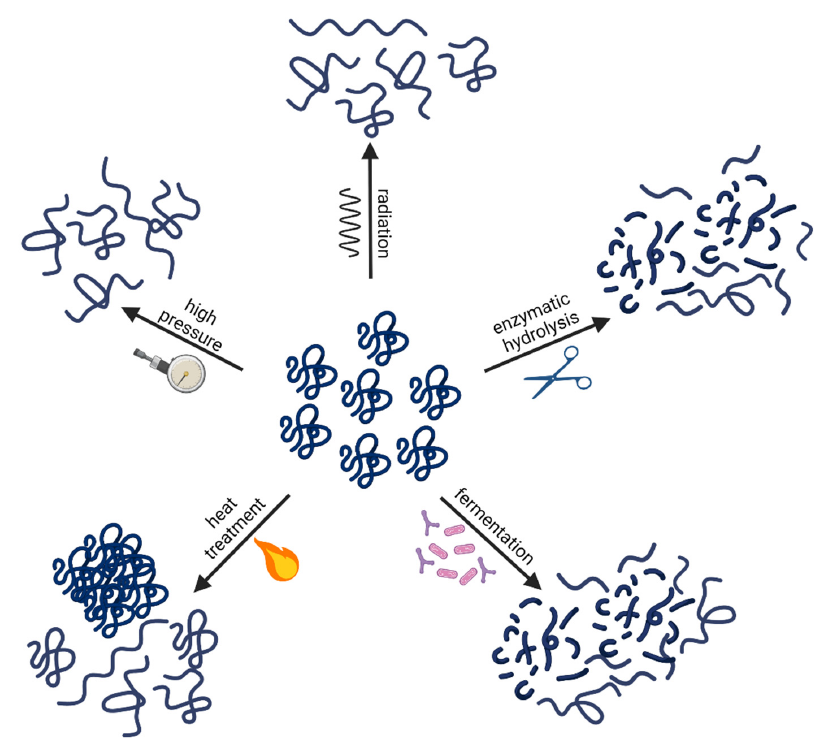
Figure 3 . Common protein structural modifications induced by different processing technologies. Figure 3. Common protein structural modifications induced by different processing